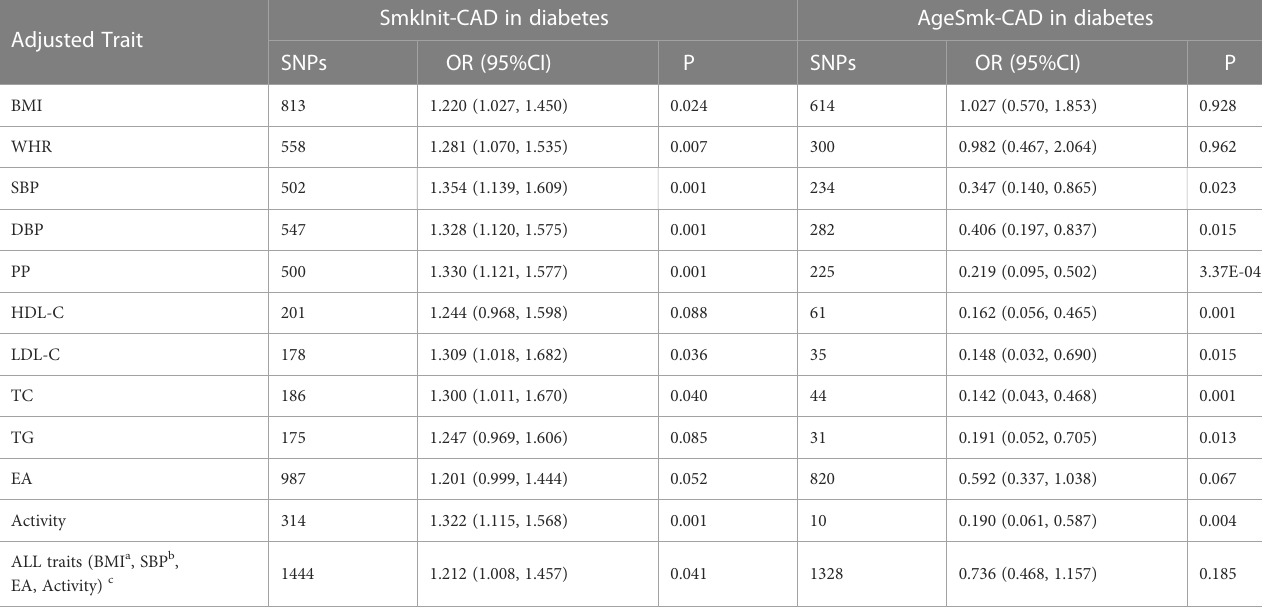
TABLE 3 Multivariable Mendelian randomization results for association of smoking initiation and age at initiation of regular smoking with coronary artery disease in patients with diabetes.